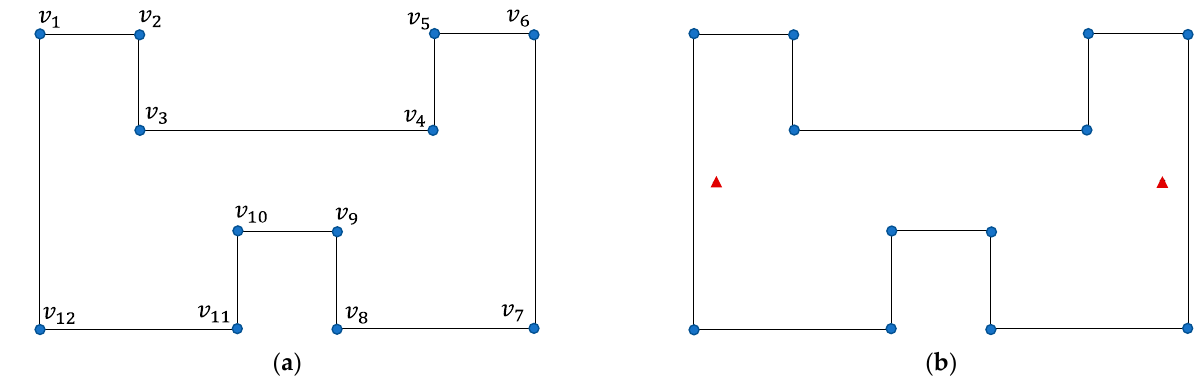
Figure 1. An example. ( a ) Input polygon; ( b ) viewpoint solution.